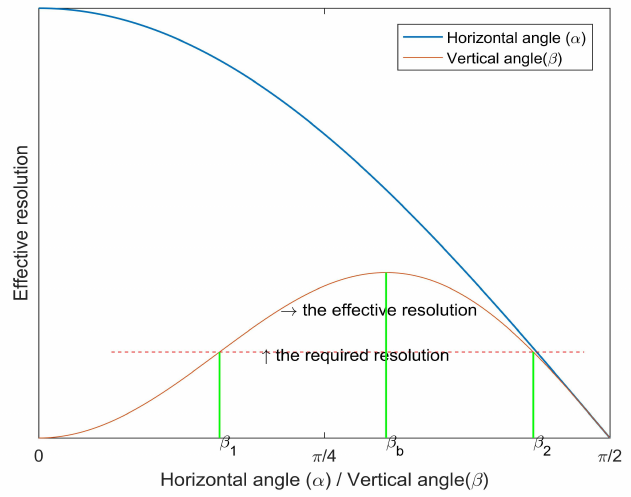
Figure 12. The effective resolution based on the ROI vs. horizontal angle (or vertical